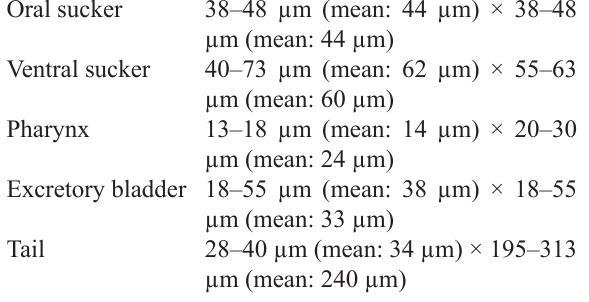
Type 8. Gymnocephalous cercariae (Fig 17) The body is oval and covered with spines. The terminal oral sucker is equipped with minute spines. Eyespots are absent.